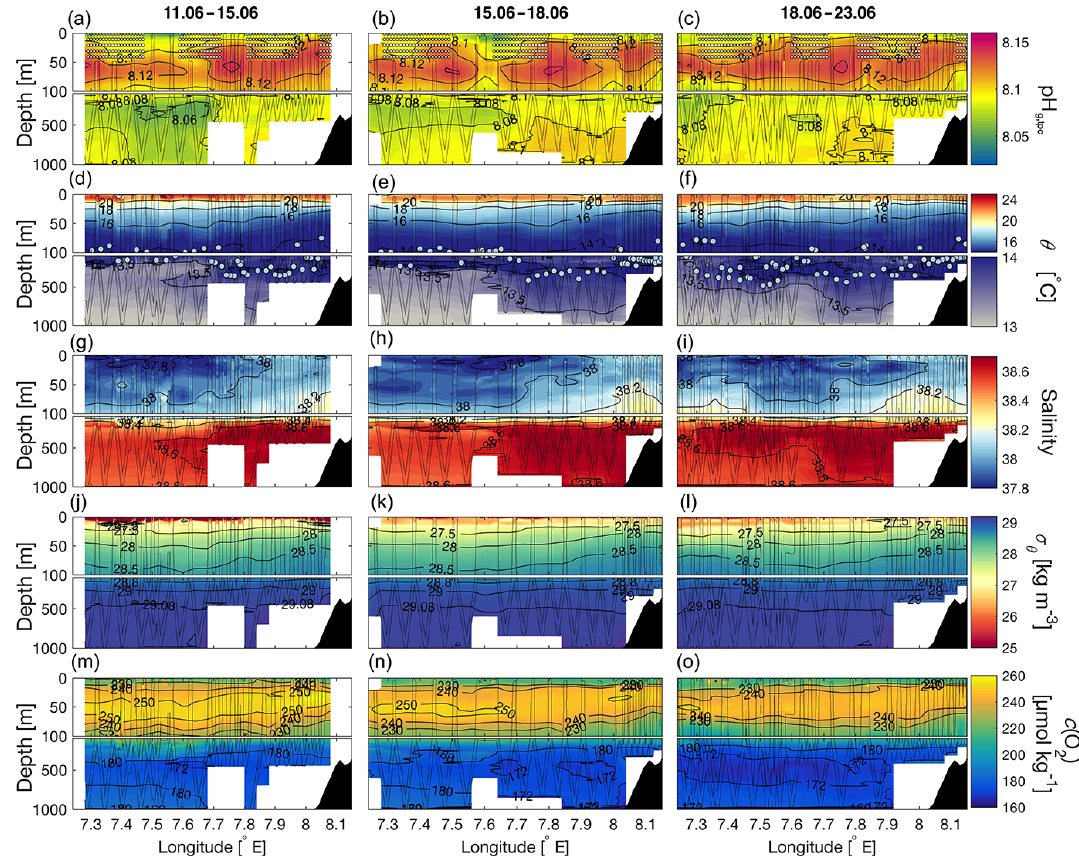
Figure 12. Objectively mapped transects of glider-retrieved (a–c) pH corrected for drift, temperature, and pressure (pH g , tpc ). (d–f) Potential temperature ( θ ), (g–i) salinity, (j-l) potential density anomalies ( σ θ ), and (m–o) dissolved oxygen concentrations ( c (O 2 )) for three different time periods between 11 and 15, 15 and 18, and 18 and 23 June 2014. The spatial ranges of pH measurements affected by light and removed prior to corrections are represented by small white points (a–c) . The depth–longitude points at which pH offsets were calculated at a temperature of 14 ◦ C are indicated by pale blue points (d–f) . Glider measurements were sorted into 0.04 ◦ longitude × 2m bins, and the radius of influence used for optimal interpolation was 0.1 ◦ longitude × 10m. Glider measurements used for optimal interpolation are superimposed on the interpolated fields for